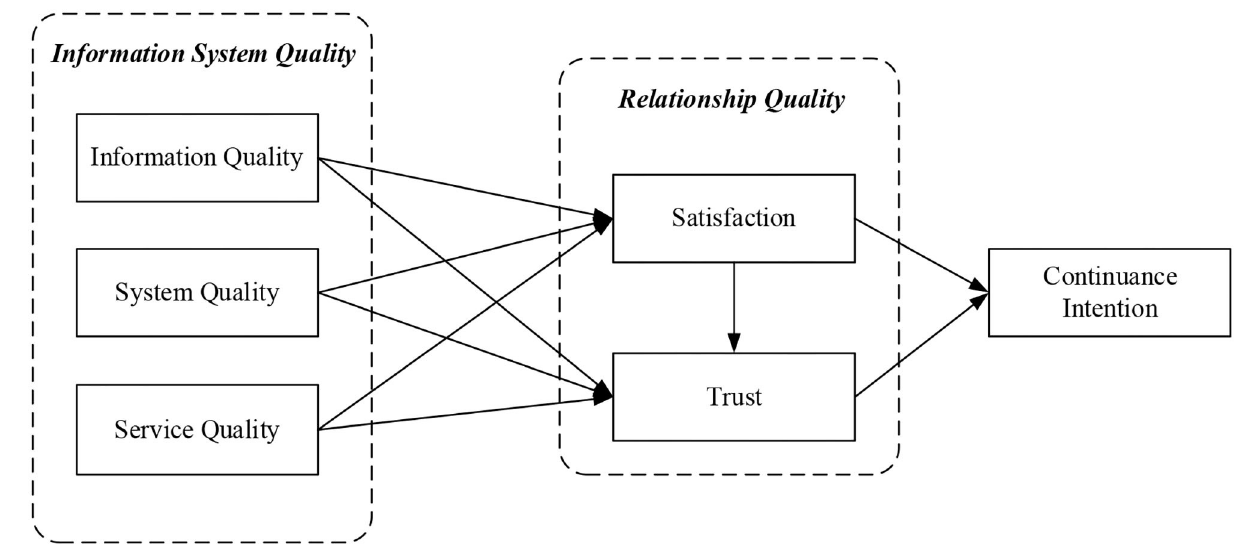
FIGURE 2 | Research